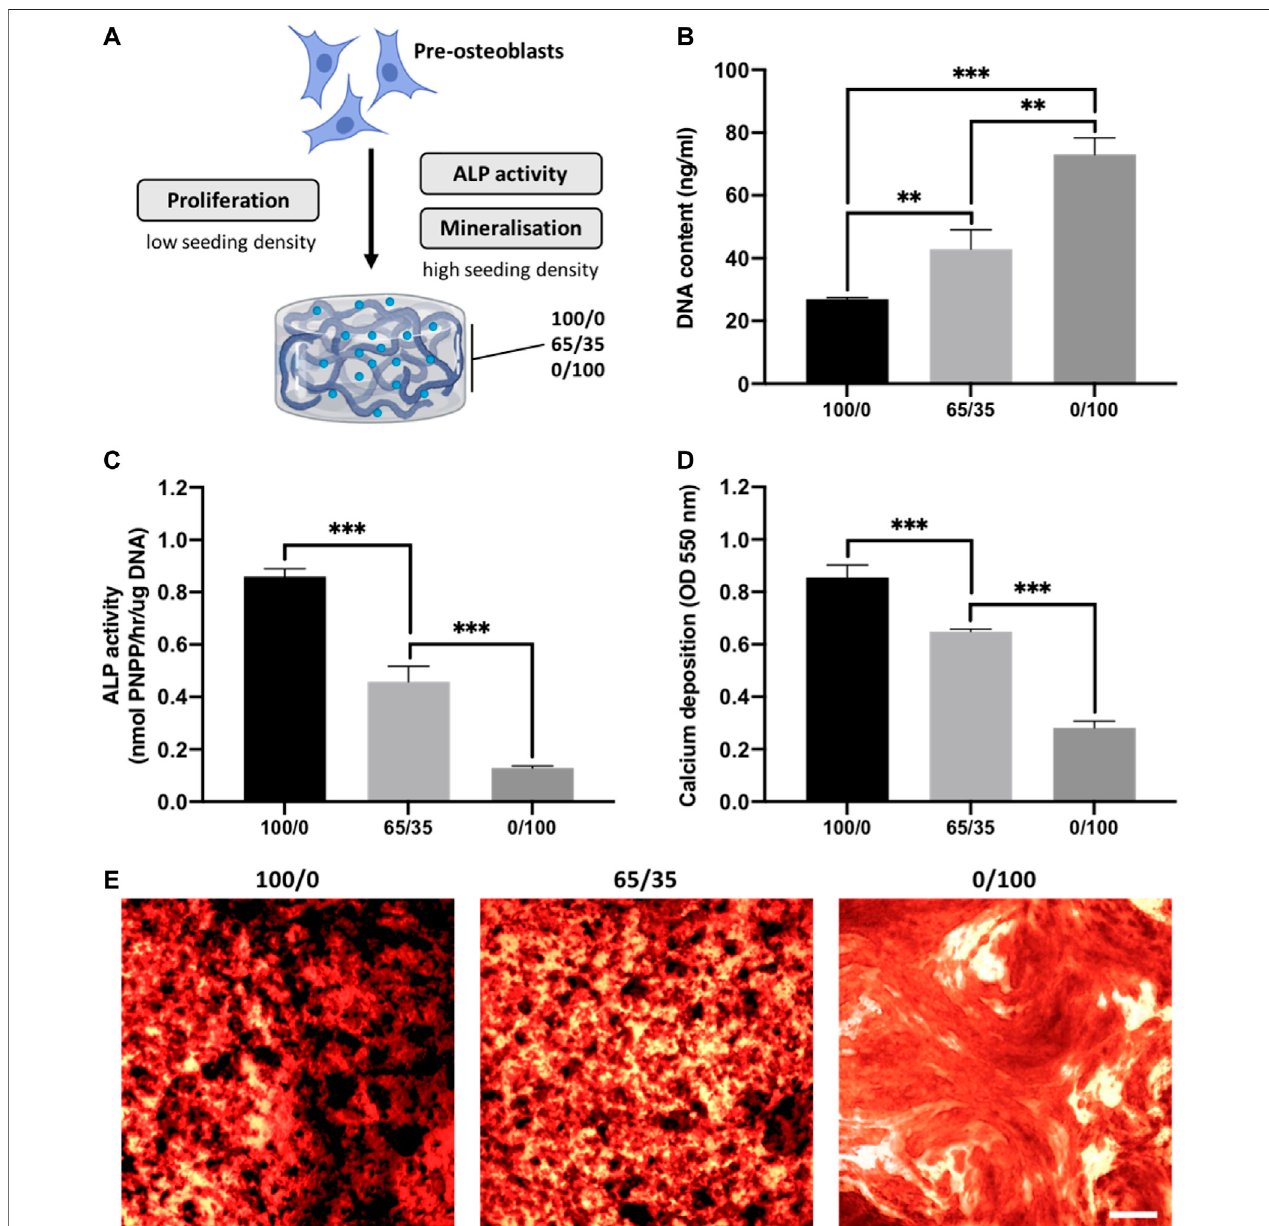
FIGURE 3 | The effects of chitosan-collagen composite hydrogel on proliferation and osteogenic differentiation. (A) Schematic representation of functional assessments.Thein fl uenceofdifferenthydrogelformulationson (B) proliferation, (C) ALPactivityand (D,E) calciumdeposition.Blackstainingindicatesmineralnodules. Scale bar = 200 µm. Data are expressed as mean ± SD ( n = 3). * p ≤ 0.05, ** p ≤ 0.01, and *** p ≤ 0.001.